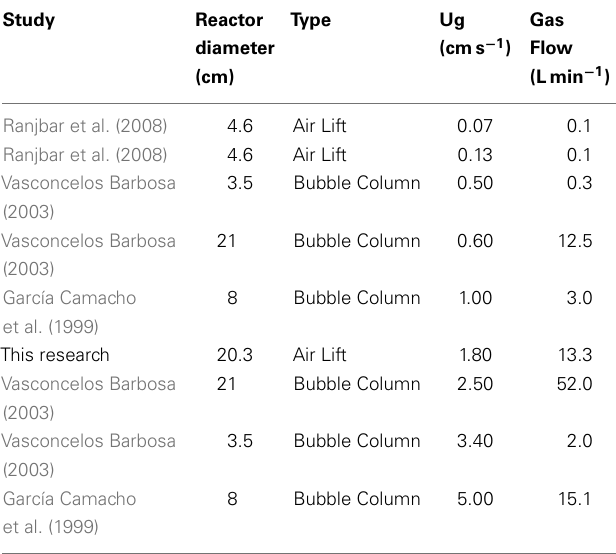
Table 3 | Calculated superficial gas velocities for previous air-lift and bubble column reactors reported in the literature